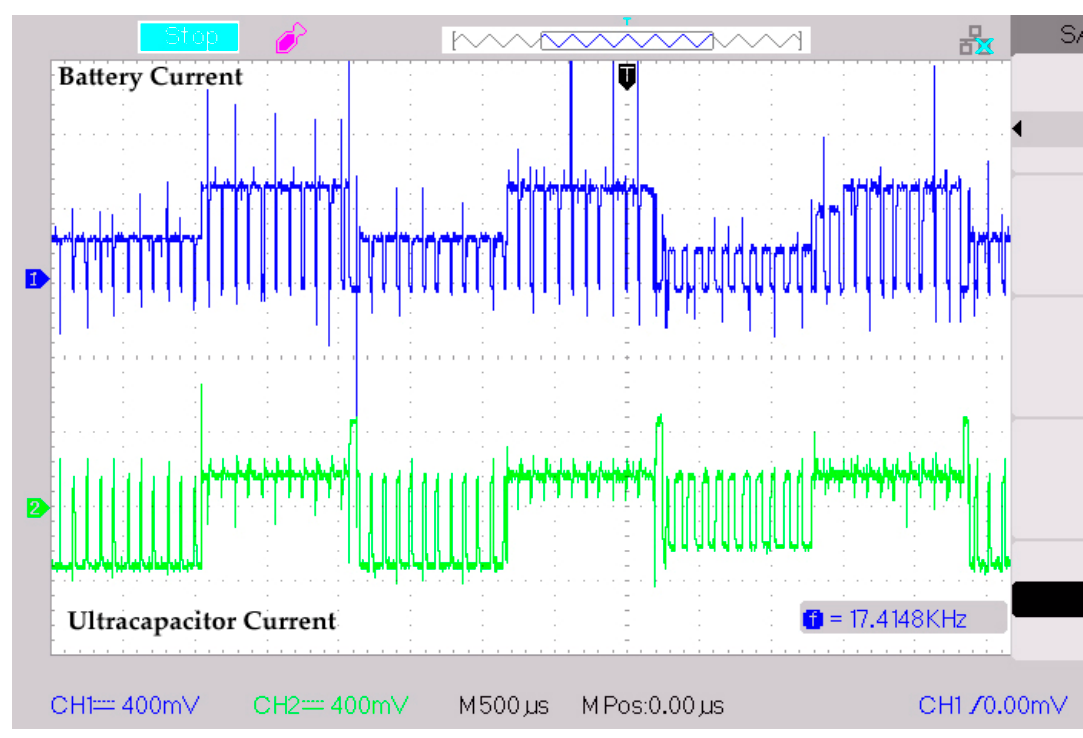
Figure 38. Battery and ultra-capacitor currents, mode-2, mode-1with t 1 = 0.5 ms, t 2 = 0.5 ms.